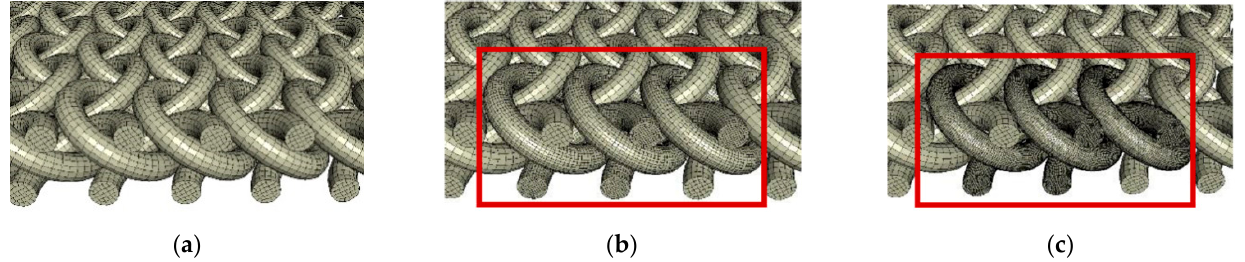
Figure 17. Variations of discretization used in the mesh sensitivity study: ( a ) base size; ( b ) mesh size 0.5–0.25 mm and ( c ) mesh size 0.5–0.125 mm.